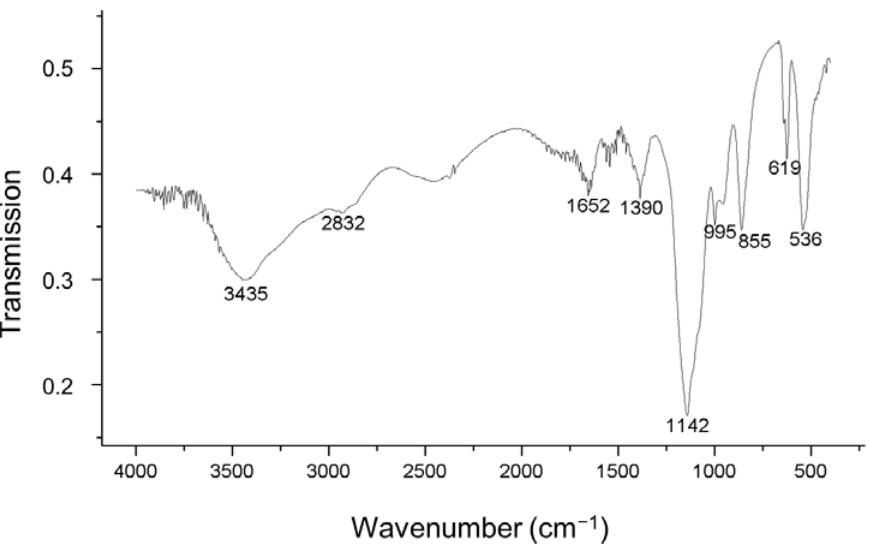
Figure 4. Representative FTIR spectrum of EPS produced by A. copahuensis cells grown with